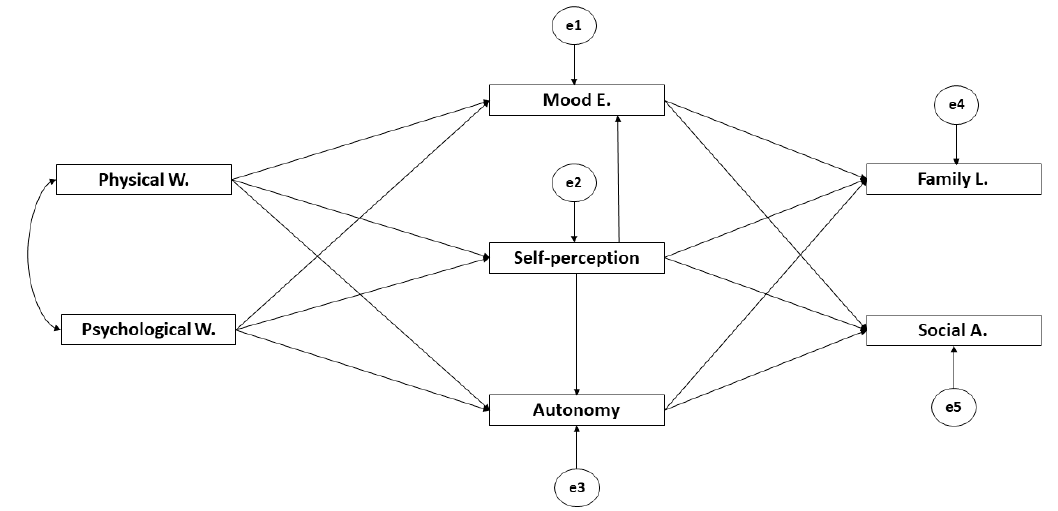
Figure 1. Theoretical